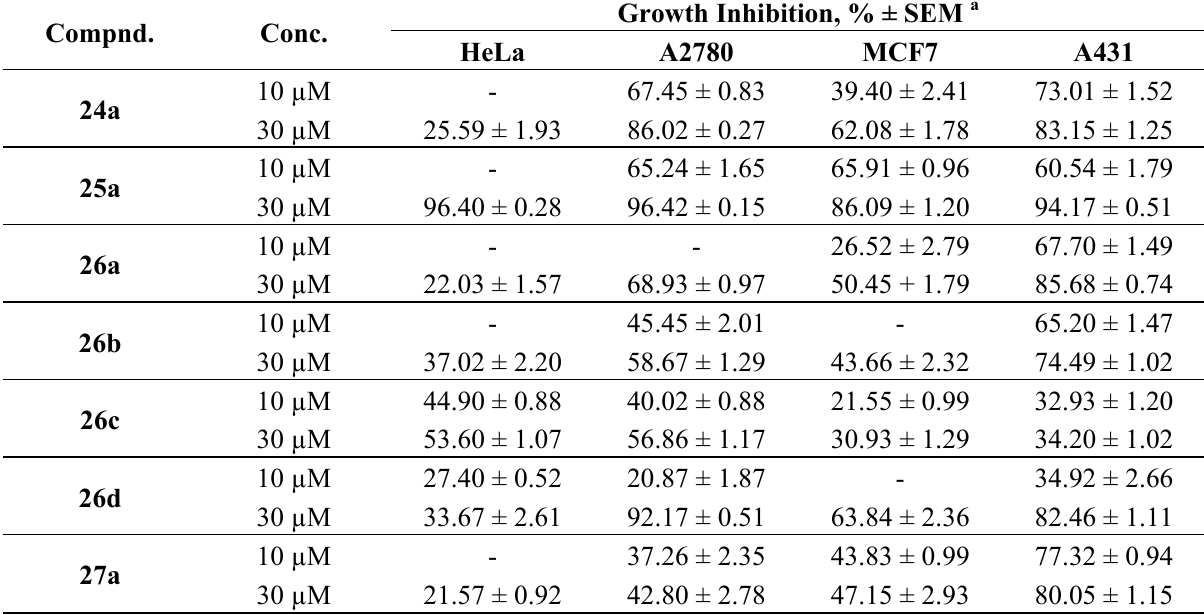
Table 3. Antiproliferative effects of 2-imino-1,3-thiazines 24 – 28 , 42 , 43 and 2-thioxo-1,3- oxazine 35 on human cancer cell lines.